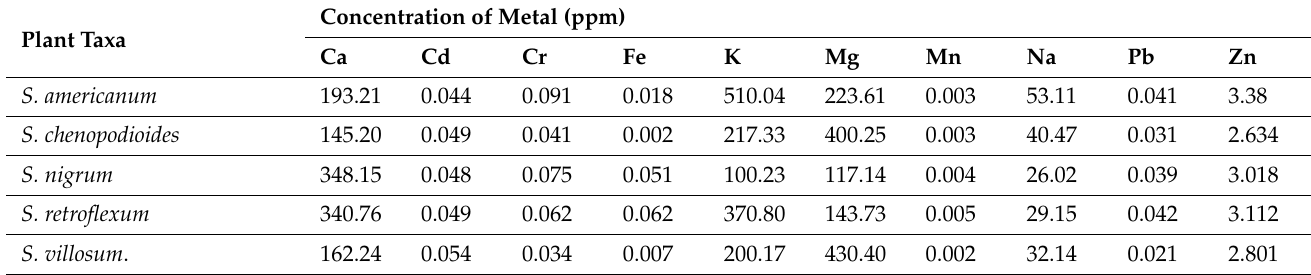
Table 3. Determination of metals in the S. nigrum